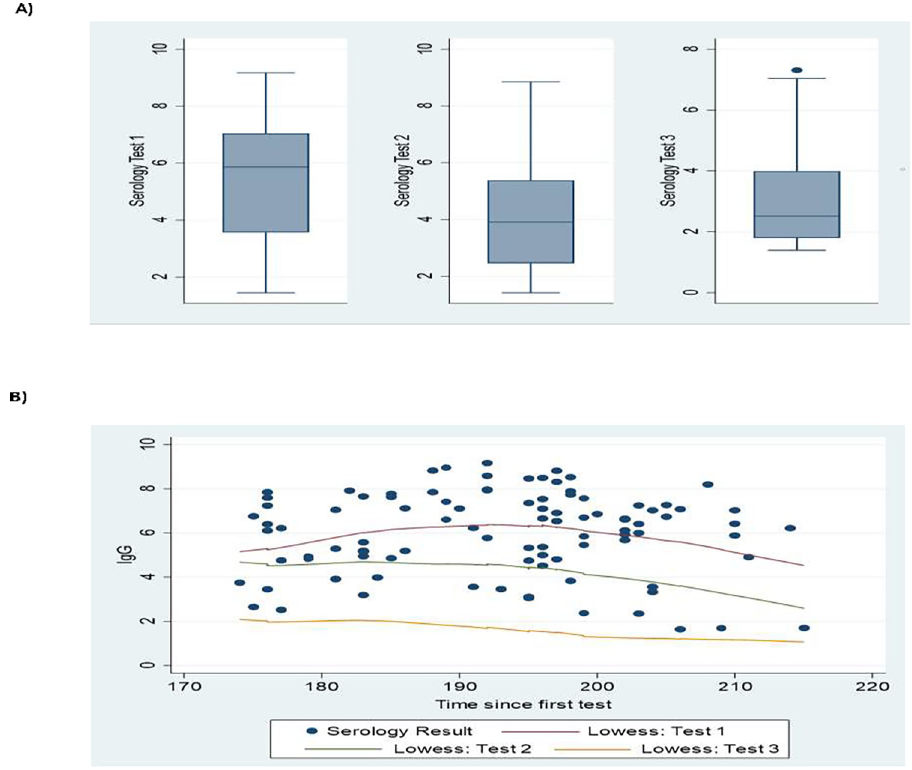
Fig 2. Trend in the titer of IgG over the study period as. (A) Median. (B) Line plot (Lowess smoother).